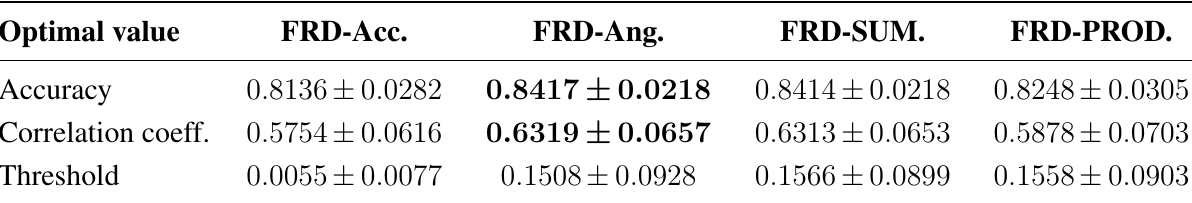
Table 12. Algorithms applied to real signals. Average Accuracy, Correlation coefficient and associated parameters (Filtered Rectifier Detector (FRD)).